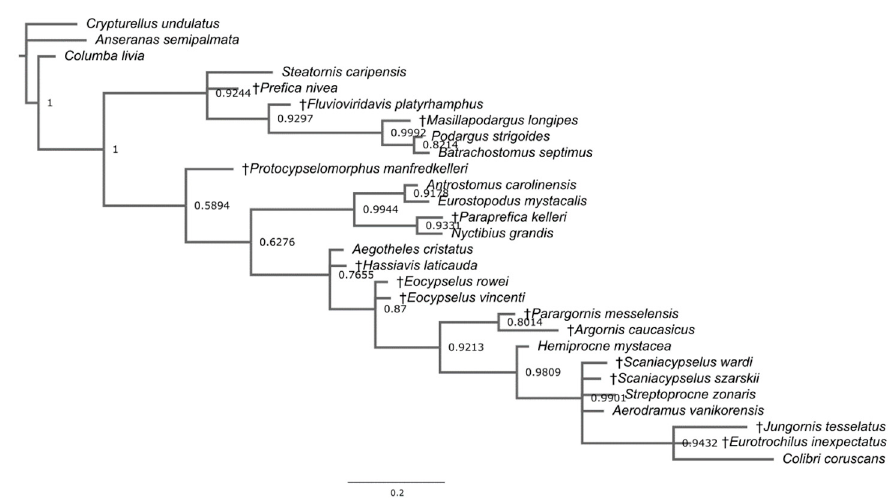
Figure 3. 50% majority-rule tree resulting from Analysis 2 (run with only morphological data). Numbers on nodes represent Bayesian posterior probabilities. Dagger (†) indicates extinct taxa.